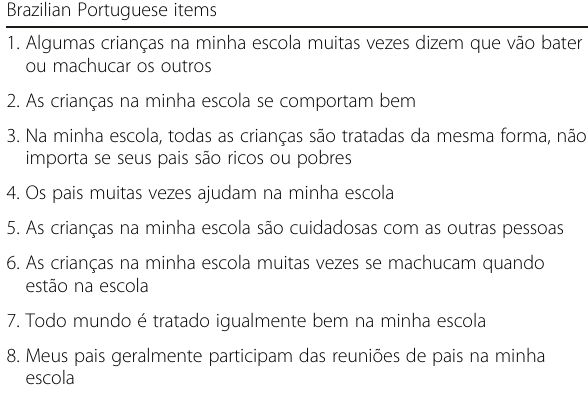
Table 3 Brazilian Portuguese items of the School Climate Survey – Revised, Elementary and Middle School Version (SCS-MS)